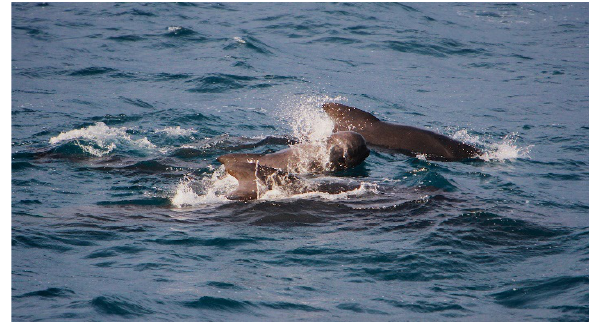
Figure 8. Long-finned pilot whales. Photo credit: Natural History Museum, Faroe Islands. None of the NASS have covered the total summer range of long- finned pilot whales in the Northeast and Central Atlantic. Long- finned pilot whales occur to the east and southeast of the survey area off Britain, Ireland in the Bay of Biscay (Buckland et al., 1993; Hammond et al., 2017; Rogan et al., 2017). Recent estimates from this general area, corrected for whales missed by observers but not for submerged whales, range from 172,195 (CV=0.35, 95% CI 88,194 – 336,206) in 2005-7 (Rogan et al., 2017) to 25,577 (CV=0.35, 95% CI 13,350 – 49,772) in 2016 (Hammond et al., 2017). The former estimate included a larger area and is likely more